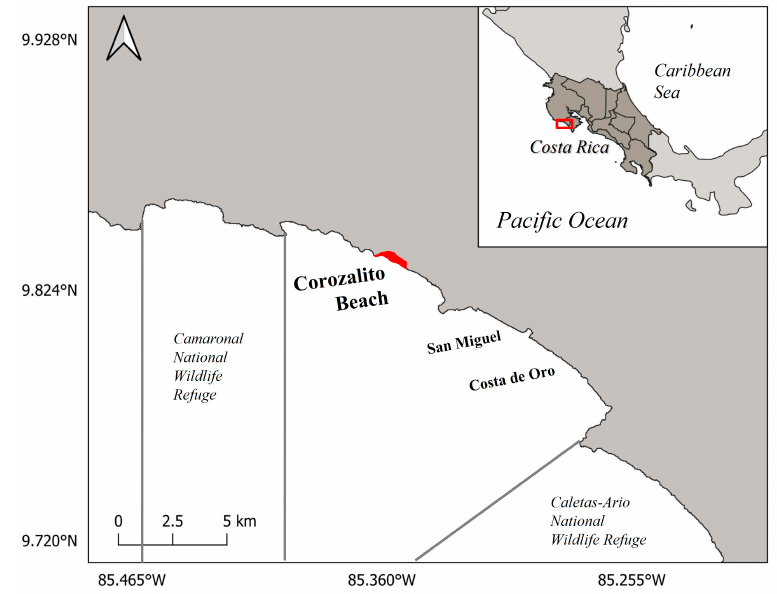
Figure 1. Geographical location of Corozalito and the surrounding Marine Protected Areas of the Camaronal and the Caletas-Ar í o National Wildlife Refuges, southern Nicoya Peninsula, Costa Rica. Bold red represents the monitored